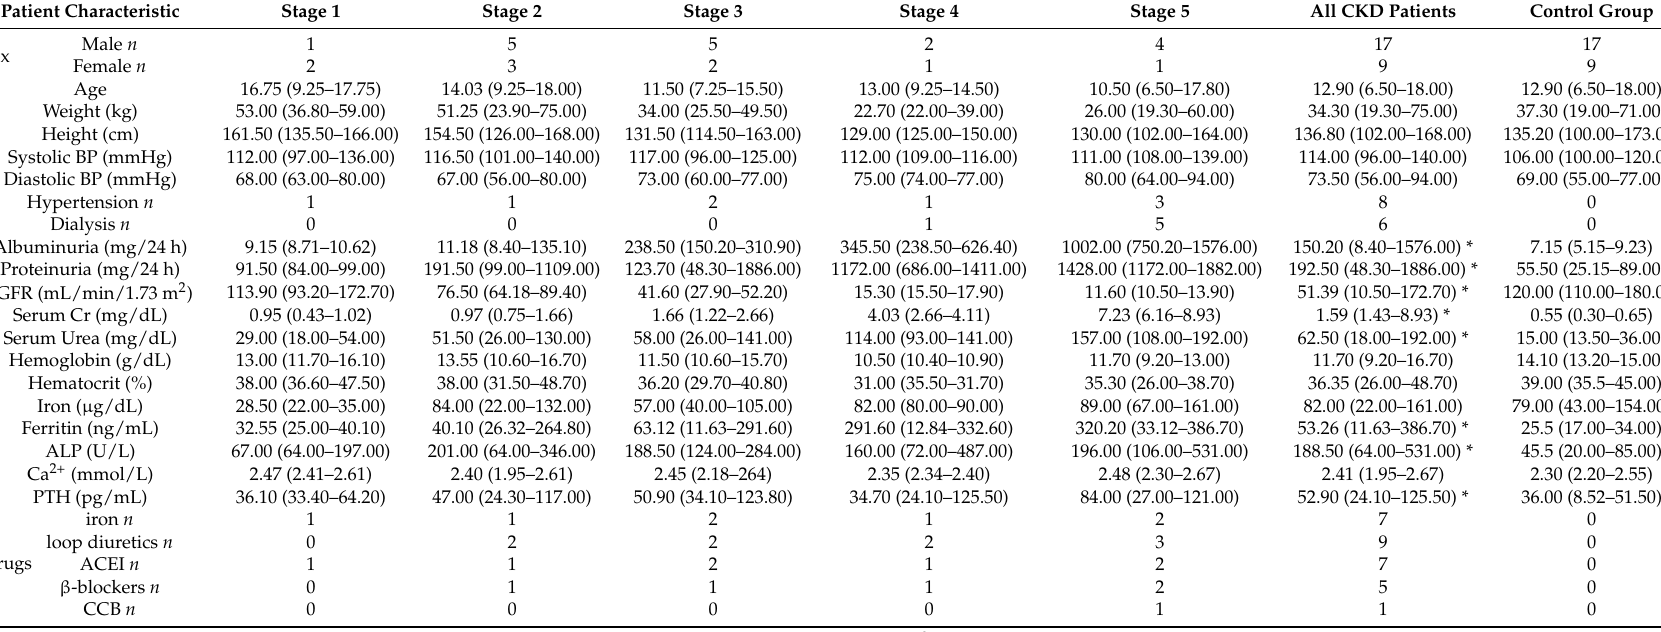
Table 1. Clinical and laboratory data of children with chronic kidney disease (CKD) and healthy